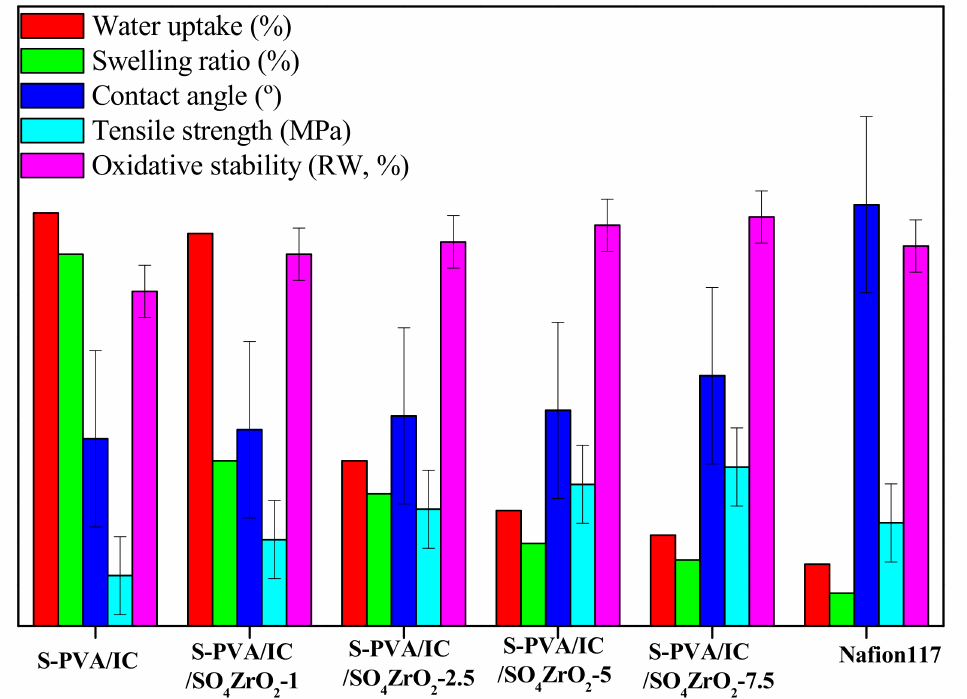
Figure 5. Physicochemical properties of the fabricated membranes and Nafion